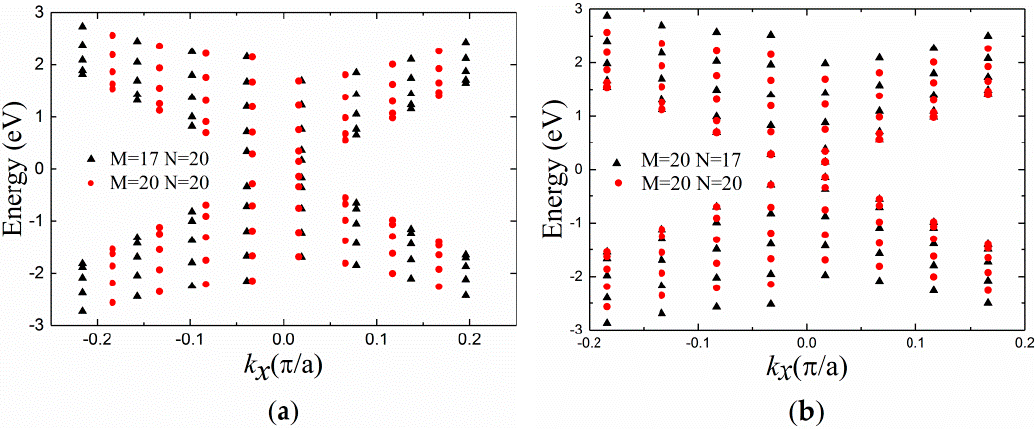
Figure 2. Energy spectra of M = 3 M 0 ± 1 sized RGQDs as a function of k x . ( a ) RGQD with the sizes M = 17, 20, and fixed N = 20; ( b ) RGQD with the sizes N = 17, 20, and fixed M = 20.